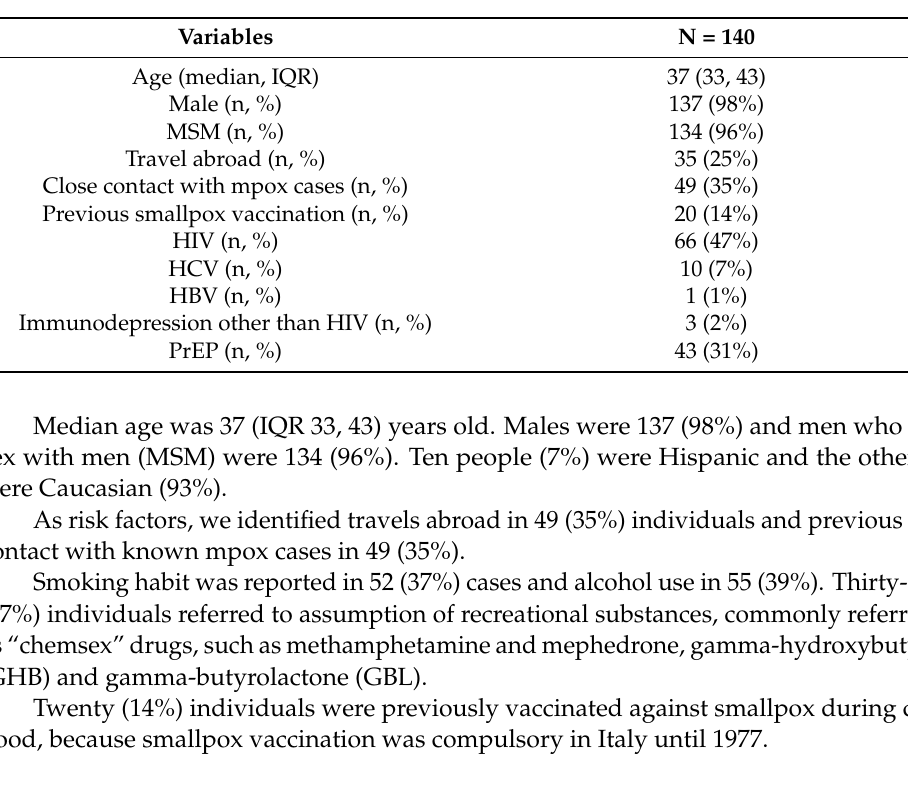
Table 1. Patients’ descriptive